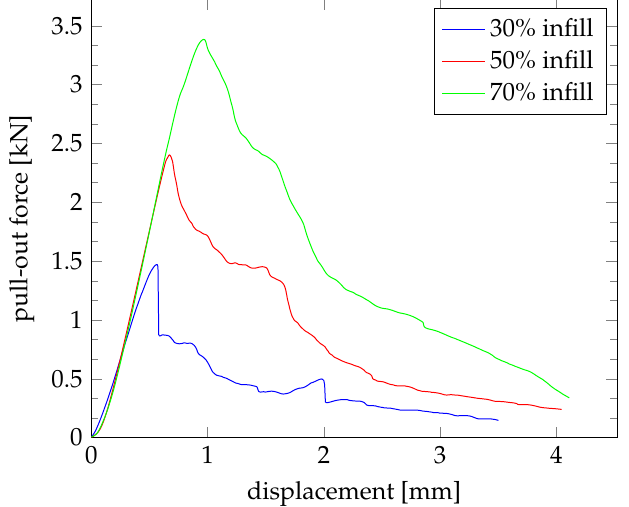
Figure 6. Exemplary characteristic force-displacement graphs of the pull-out tests for variations of the infill density.